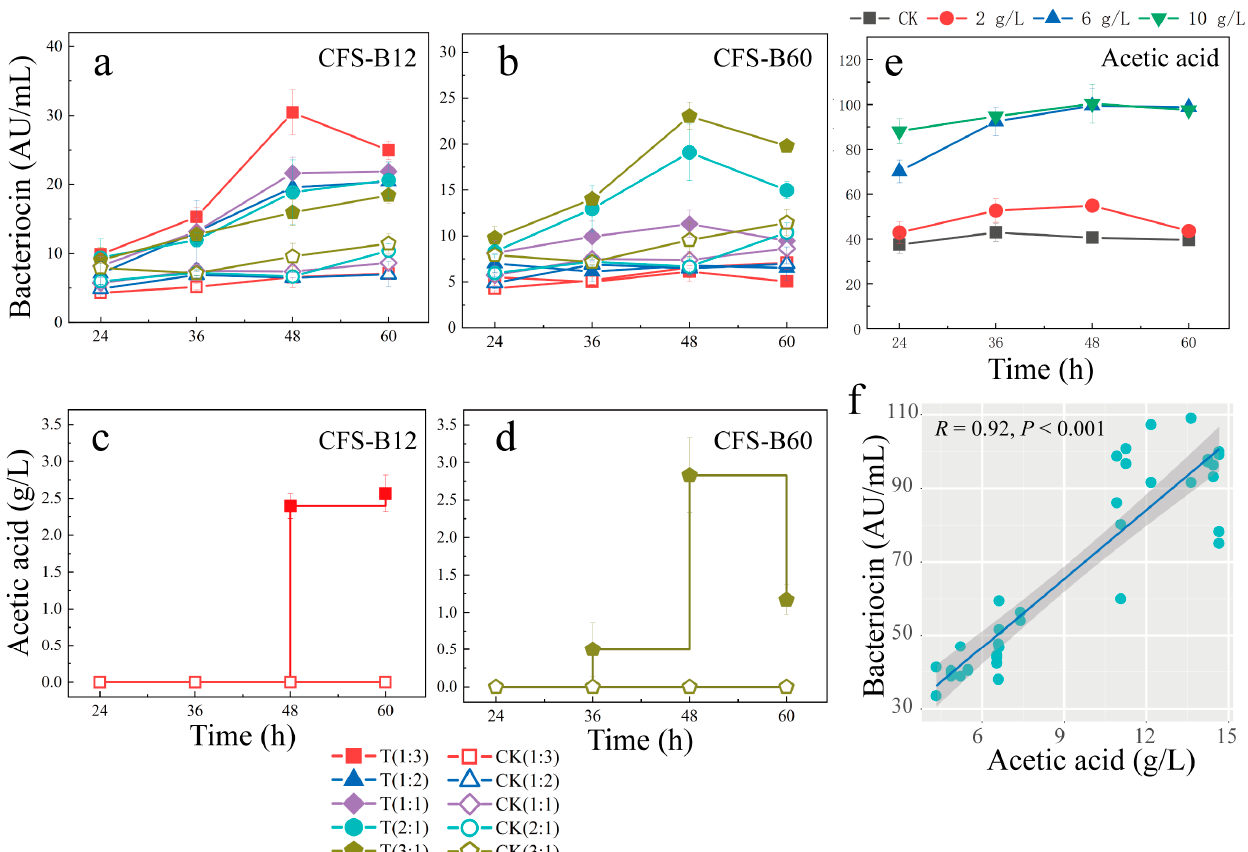
Figure 1. Effects of CFS and acetic acid on bacteriocin production: ( a , b ) effects of different ratios of CFS on bacteriocin production; ( c , d ) effects of CFS on acetic acid production by L. paracasei HD1.7; ( e ) effects of different concentrations of acetic acid stress on bacteriocin production; ( f ) bacteriocin production was positively correlated with extracellular acetic acid. CFS-B12 represents the cell-free supernatant of B. subtilis ATCC 11774 cultured for 12 h; CFS-B60 represents the cell-free supernatant of B. subtilis ATCC 11774 cultured for 60 h. T (1:3) represents the volume ratio of L. paracasei HD1.7 to CFS at 1:3, CK (1:3) represents the control group, and water replaced CFS.